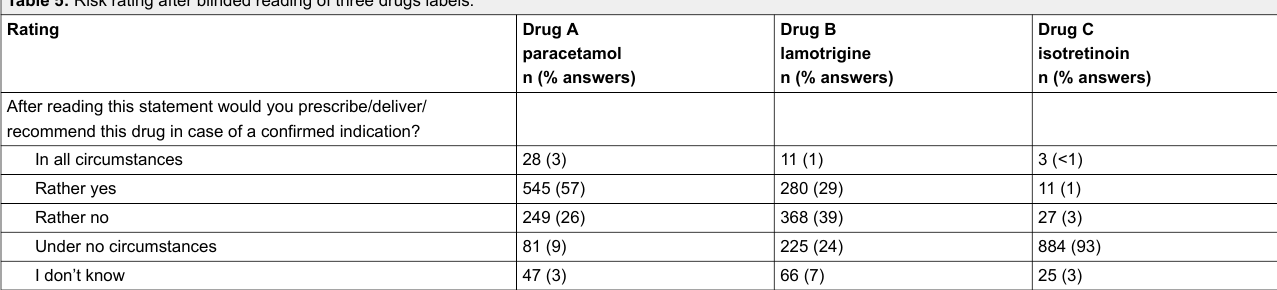
Table 5: Risk rating after blinded reading of three drugs